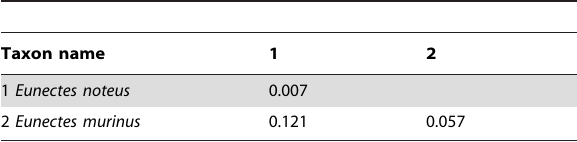
Table 2. Kimura’s two parameter (K2P) distance, for cytochrome b , within and among continental Epicrates spp.